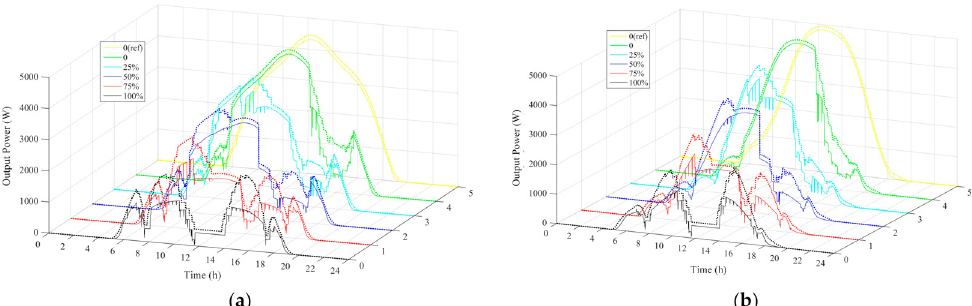
Figure 10. Output powers of different overlapping areas in 24 h. ( a ) Output power of wing section 3. ( b ) Output power of wing section 4.